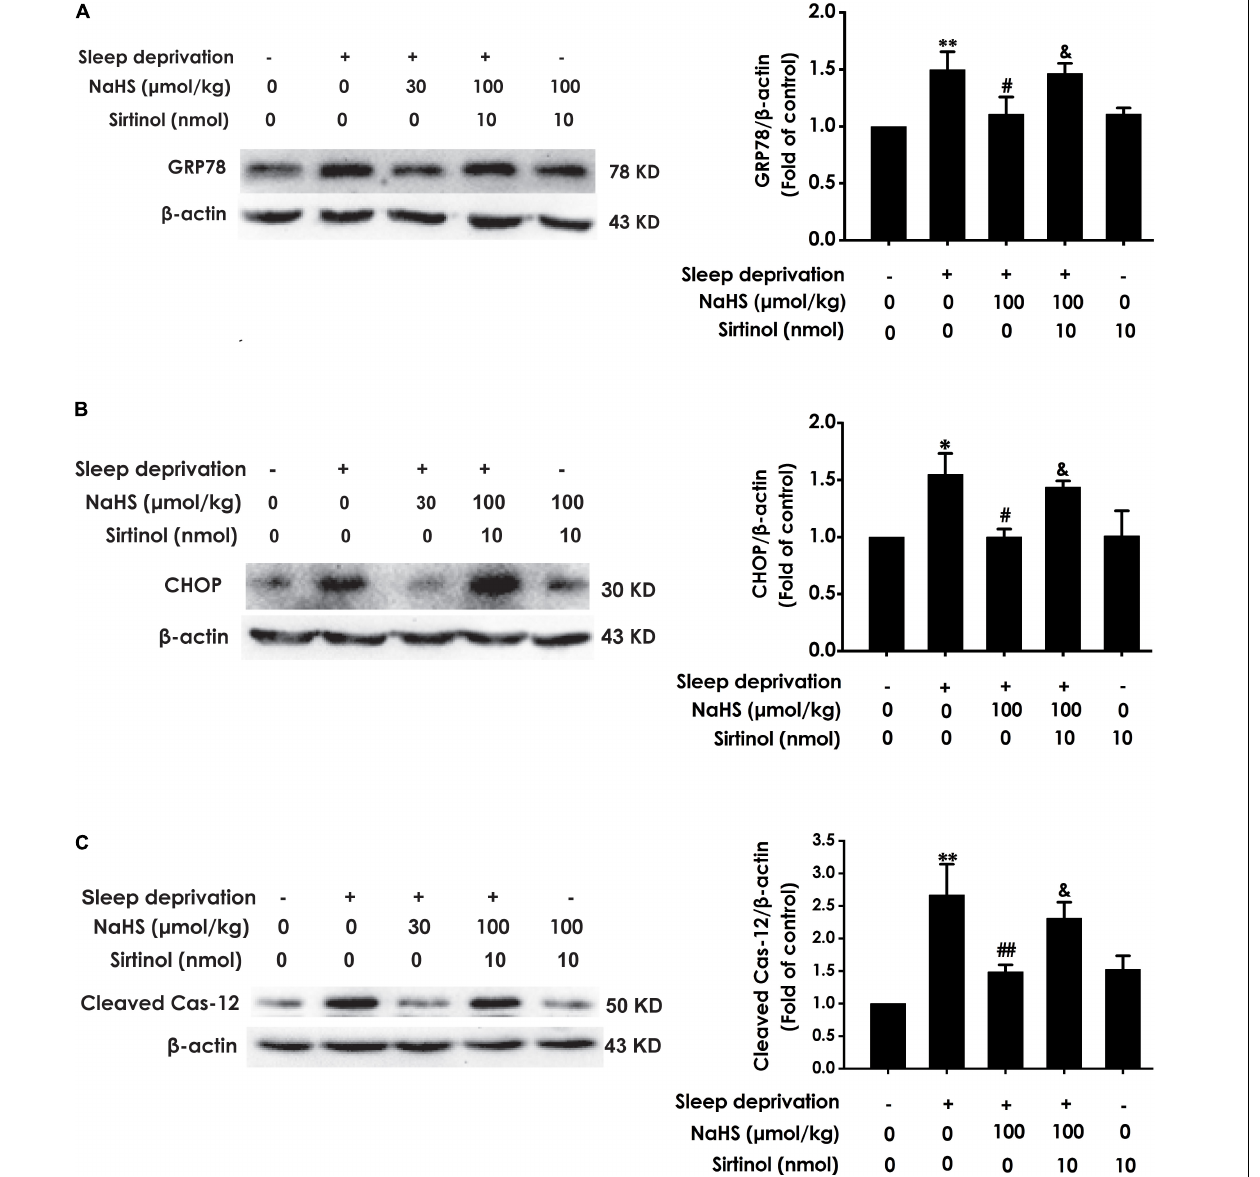
FIGURE 6 | Effect of Sirtinol on hydrogen sulfide ameliorated hippocampal ER stress in sleep deprivation-exposed rats. Rats were pretreated with NaHS (100 µ mol/kg/d, ip) for 7 days and then cotreated with SD and Sirtinol (10 nmol/d, icv) for 72 h. The expression of CPR78 (A) , CHOP (B) , and cleaved caspase-12 (C) in the hippocampus were detected by western blotting. In all blots, β -actin was used to determine control. Values are the means ± SEM ( n = 3). ∗ P < 0.05, ∗∗ P < 0.01, vs. control; # P < 0.05, ## P < 0.01, vs. SD-treated alone group; & P < 0.05, vs. cotreated with NaHS (100 µ mol/kg/d, i.p.) and SD treated